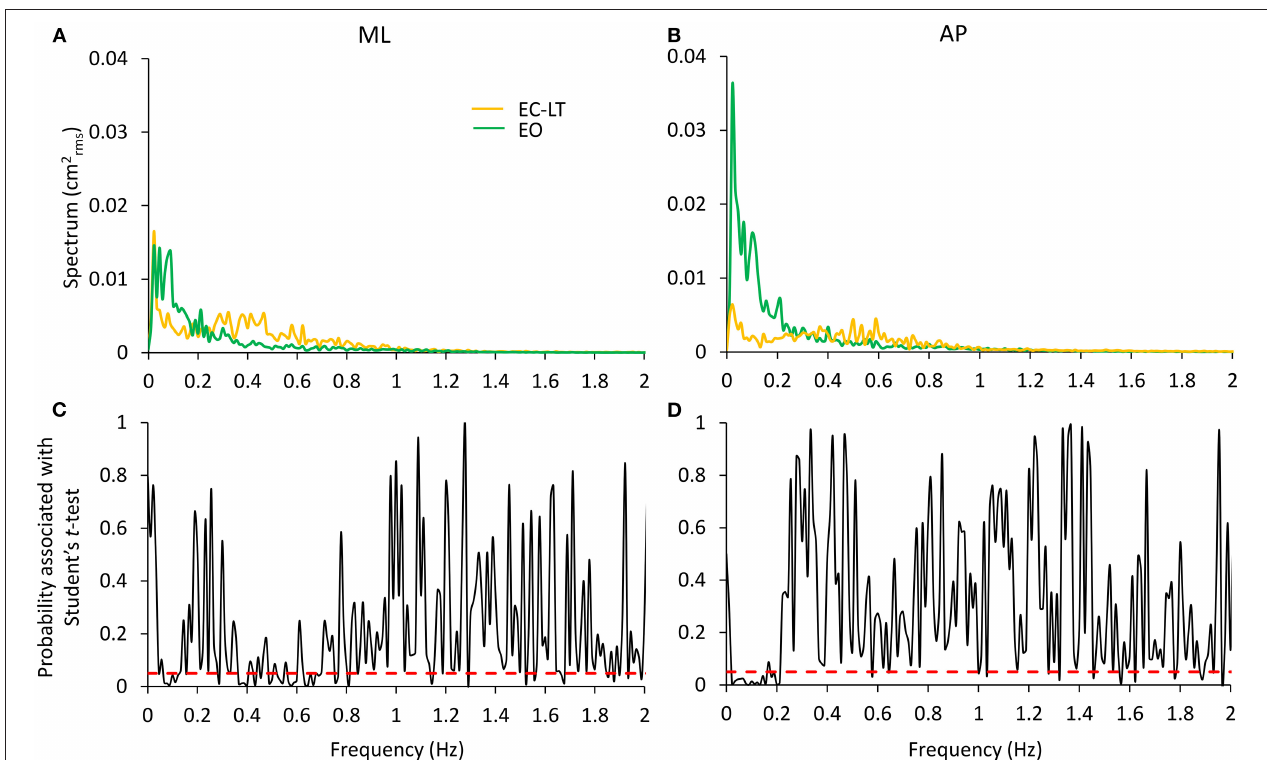
FIGURE 9 | Comparison of the effects of the “stabilising” touch and vision conditions. EC-LT (yellow) and EO (green) are compared in (A,B) for the ML and AP directions, respectively. Touch compared to vision remarkably decreases the spectrum in the very low frequency range ( range 0.3–0.8Hz. Graphs (C,D) (reporting the p -values of the point-to-point differences between the mean values of the entire spectra) show that the mean levels are significantly different in these ranges. The differences are less strong in the higher frequency range for the AP direction. The red dashed lines indicate the level at which the differences are significant at p <